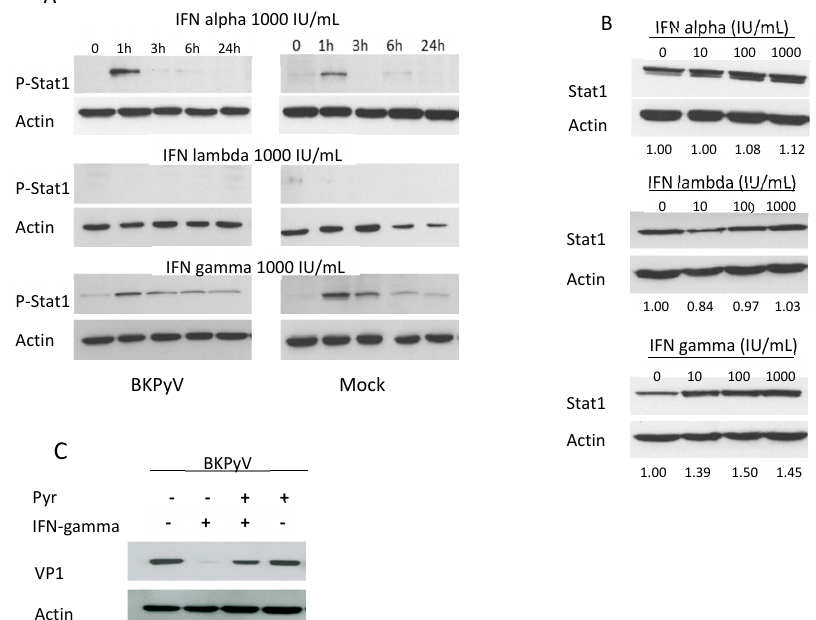
Figure 2. The Janus kinase/signal transducers and activators of transcription ( JAK-STAT) pathway is involved in IFN’s effect on BKPyV infection. ( A ) Vero cells were inoculated for 3 h with BKPyV at a MOI of 0.5. Twenty-four hours post-infection, the cells were incubated with 1000 IU/mL of IFN-alpha, -lambda or -gamma. Total cellular proteins were harvested 0, 1, 3, 6 and 24 h after IFN treatment. Phospho-Stat1 (Y 701) and actin proteins were detected by Western blotting. ( B ) Vero cells were pre-incubated for 6 h with different IFNs concentrations and then inoculated for 3 h with BKPyV at a MOI of 0.5. Total cellular proteins were harvested 72 h after infection. The IFN was present throughout the experiment. STAT1 and actin proteins were detected by Western blotting. ( C ) Vero cells were incubated 4 h with 10 IU/mL IFN-gamma in the presence or absence of 10 μ M pyridone-6 and then infected for 3 h with BKPyV at a MOI of 0.5. The IFN and pyridone-6 were present throughout the experiment. Three days after infection, total cellular proteins were extracted and VP1 and actin were detected by Western blotting. To find out which proteins might be involved in IFN-gamma’s antiviral effect on BKPyV, we analyzed the Vero cells’ transcriptomic study with a low-density array. Nine of the 64 genes studied had an induction profile that resembled that of the antiviral effect: moderate induction with IFN- alpha, poor induction with IFN-lambda and a strong induction by IFN-gamma (data not shown). Among the ISGs strongly induced by IFN gamma and poorly induced by IFN alpha, we focused on